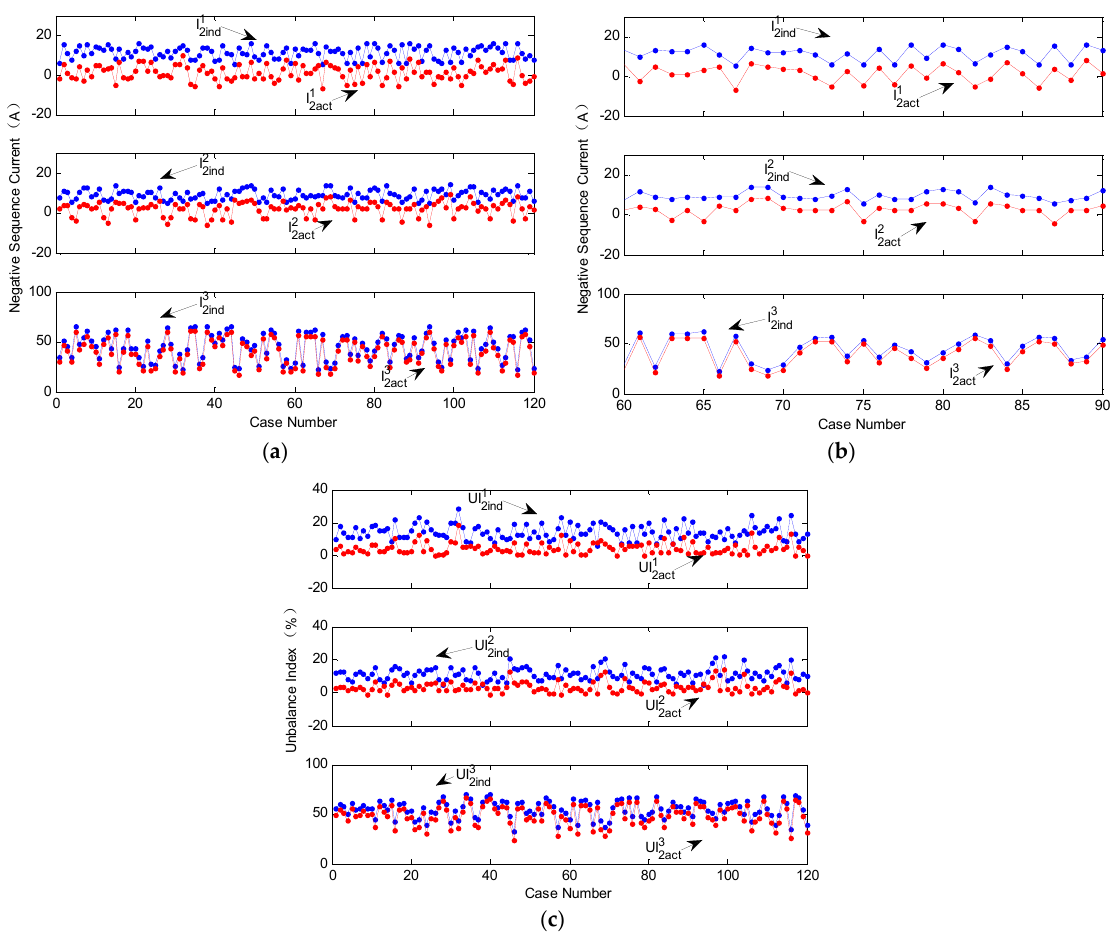
Figure 3. Relationship analysis between “individual current” and “actual current”: ( a ) amplitude variation results for all simulation cases; ( b ) enlarged view for the current results of cases 61–90; and ( c ) unbalance contribution estimation results for all cases.